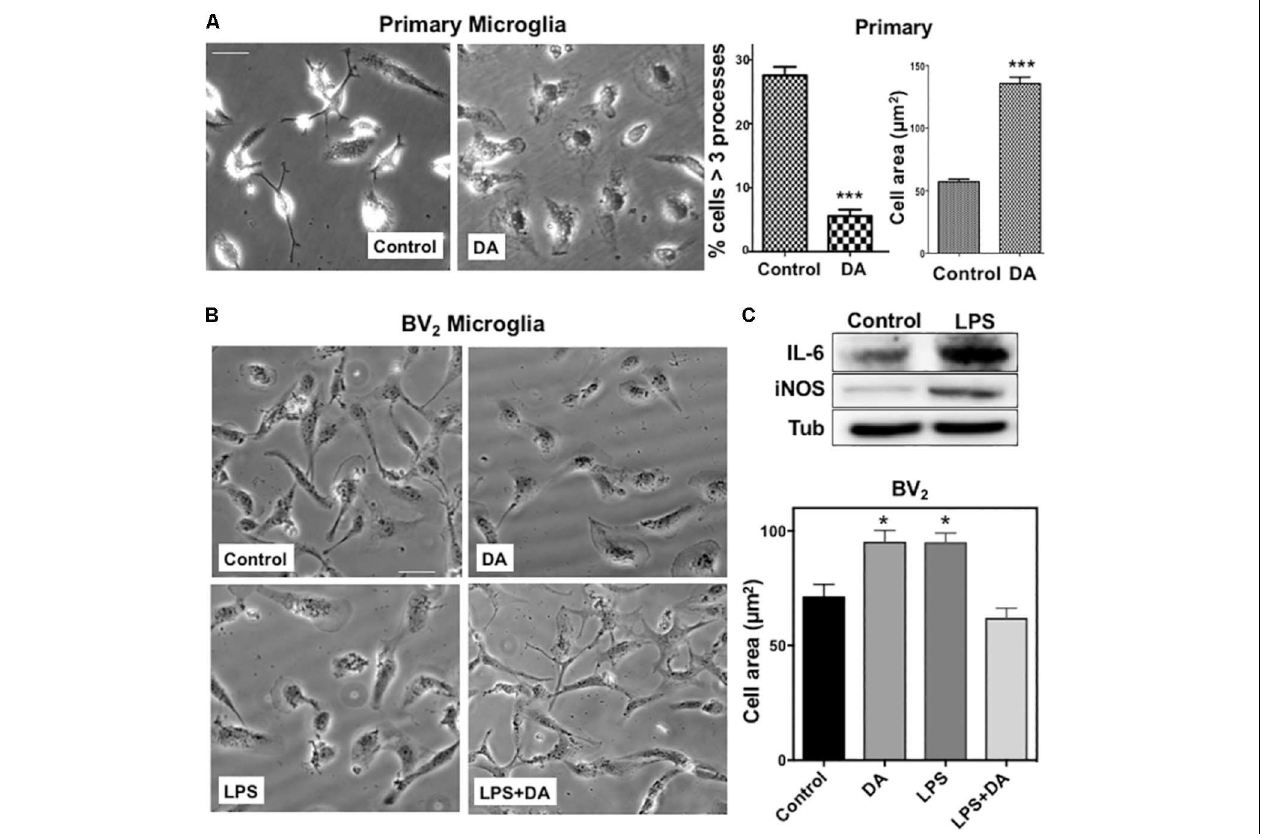
FIGURE 1 | (A) Changes in the morphology of primary microglia upon DA treatment. Primary microglia cells showed small cell body and multiple processes. Upon DA (2 µ M) treatment for 30 min, they acquired flattened morphology and area of cells were increased significantly, accompanied by a decreased number of cells having multiple processes (unpaired t -test: ∗∗∗ P < 0.005). Values are means ± standard error of 15–20 cells. Right panels show the measurements of cellular process number and cell area. (B) BV 2 microglia were stimulated with LPS and DA, and their morphology (left panels) and cell area (right panel) are shown